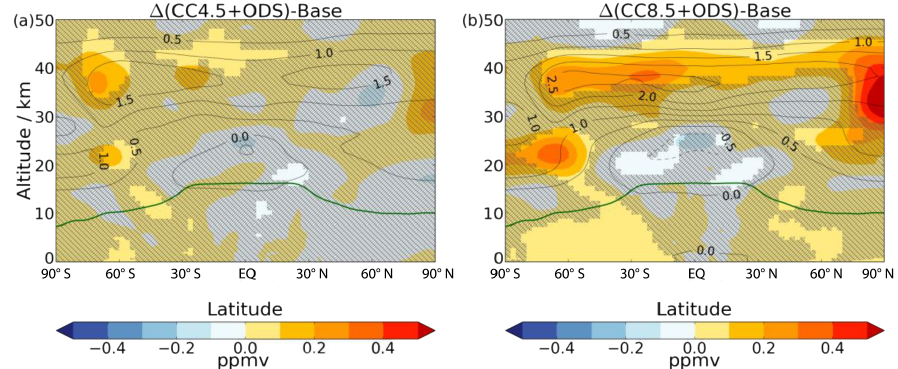
Figure 3. Changes in annual and zonal mean ozone (ppmv, contours) from Base to two combined-forcing runs: (a) (cid:49) (CC4.5 + ODS) and (b) (cid:49) (CC8.5 + ODS). The shading indicates the amount by which the response deviates from additivity (i.e. the difference between the combined-forcing experiment and the sum of the individual-forcing cases). Areas where the non-additive component of the response is not significant at the 95% level according to a Student’s t test are hatched out. The solid green line indicates the thermal tropopause of the Base